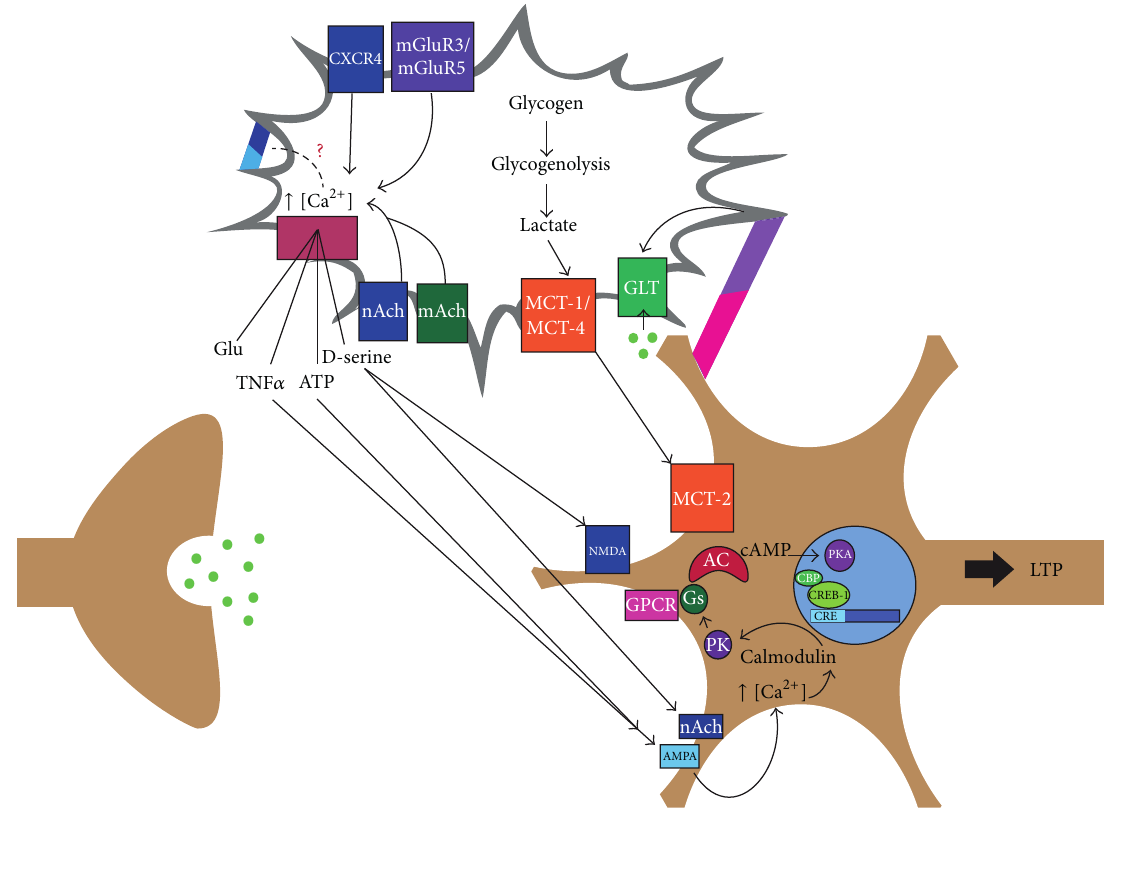
Figure 1: Integrative model of postsynaptic glia-neuron communication during memory